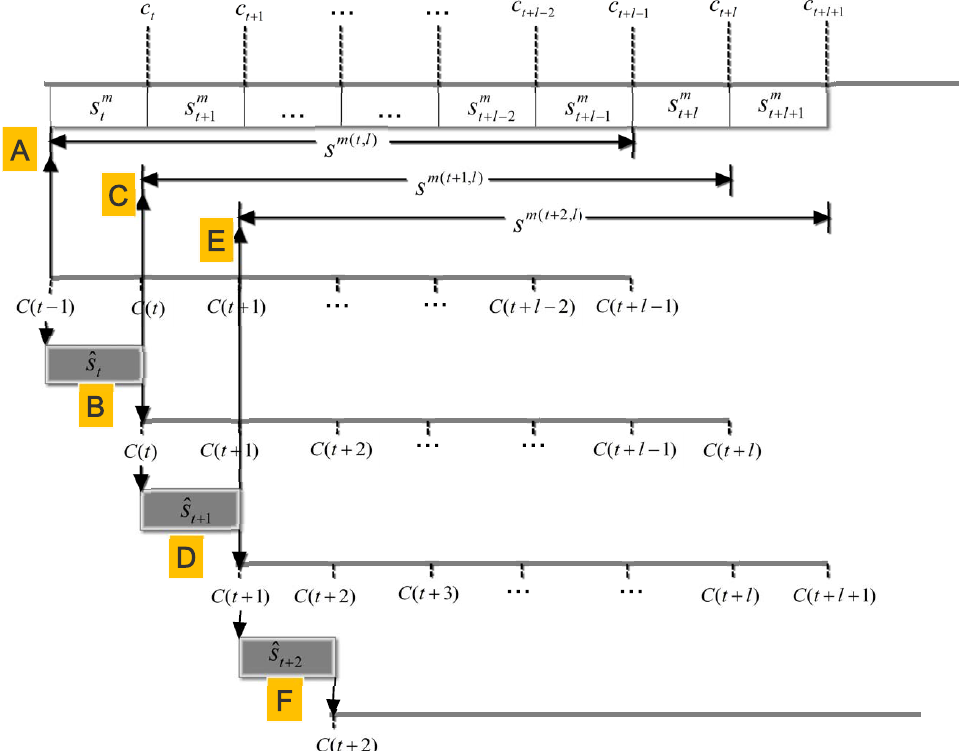
Figure 1. Illustration of three cycles in GCAS-DOM in which a state vector composes of the flux at l